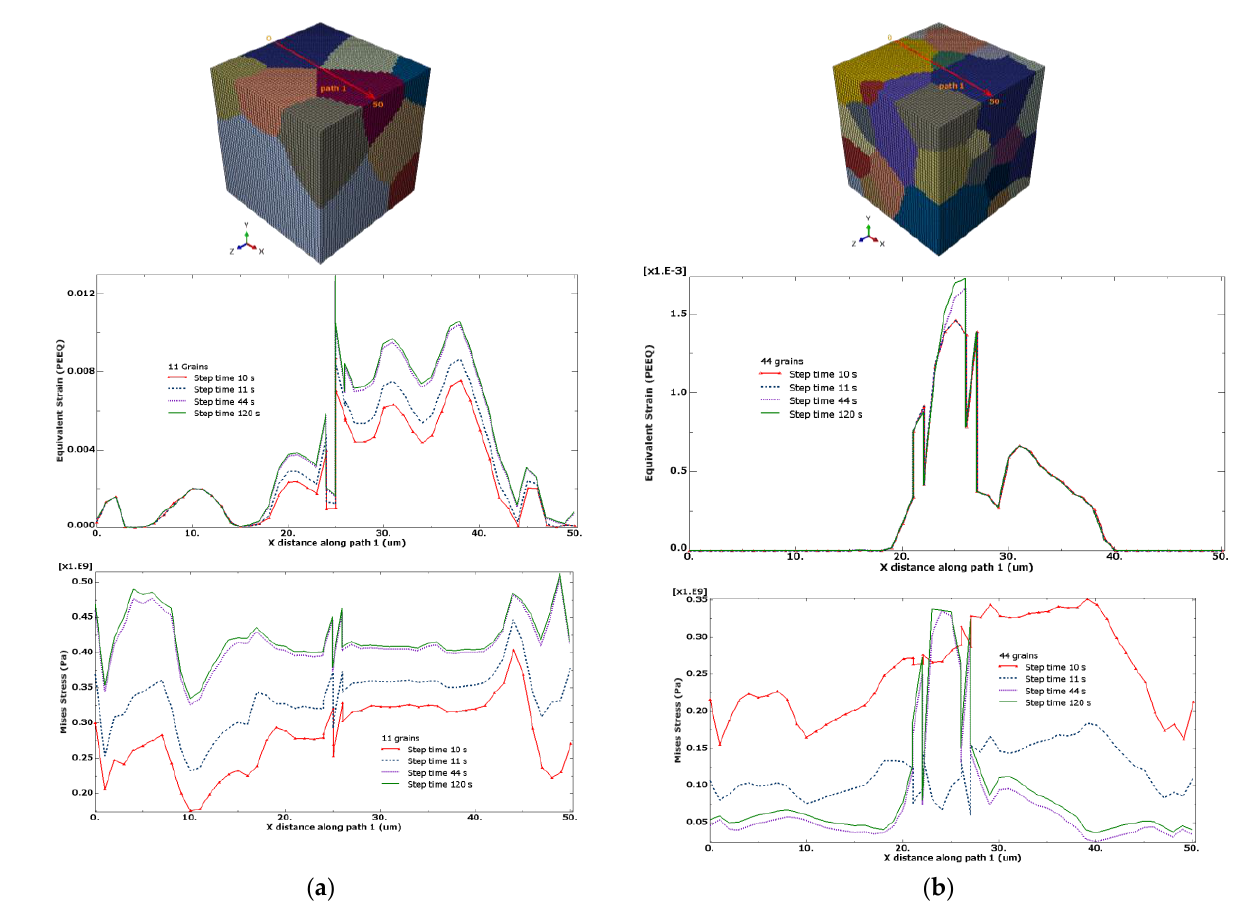
Figure 5. Equivalent strain (PEEQ) and Mises stress vs. X distance along path 1 at documented step times ( a ) for the 11 grains specimen ( b ) for the 44 grains specimen.